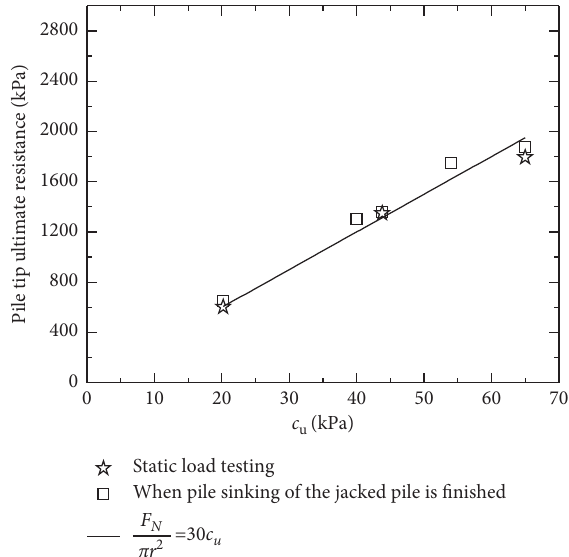
Figure 21: Ultimate pile tip resistance versus undrained shear strength of the